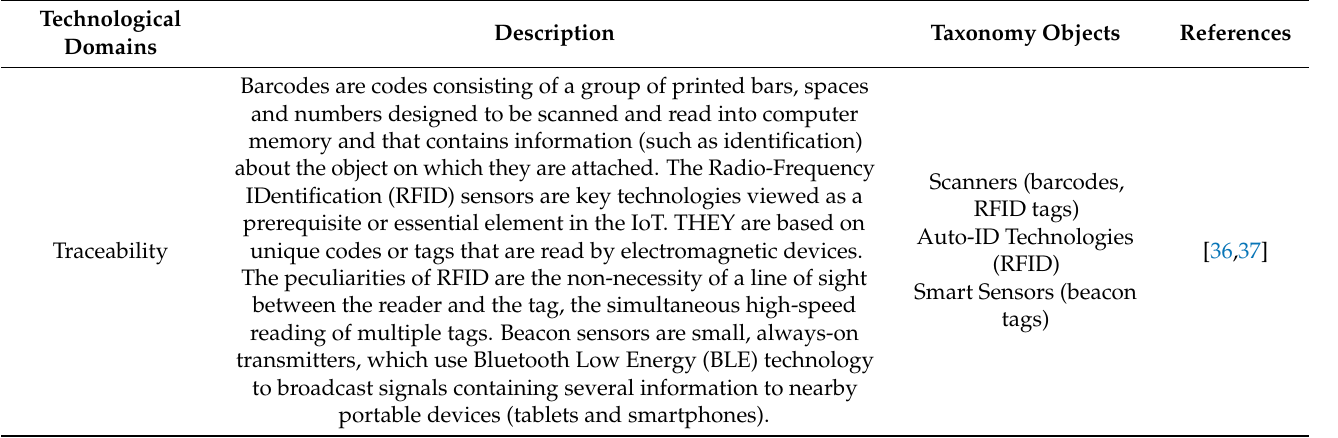
Table 5. Main technologies implemented in a logistics